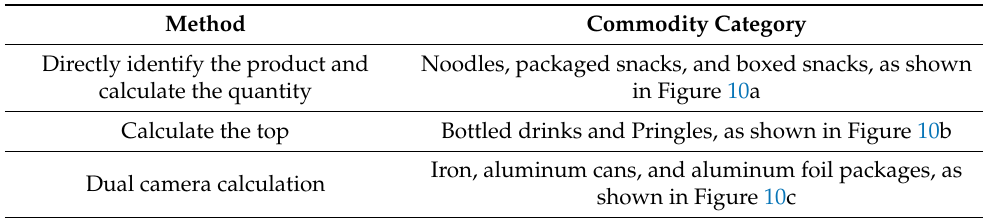
Table 2. Identification methods used for height occlusion and stacking. Method Commodity Category Directly identify the product